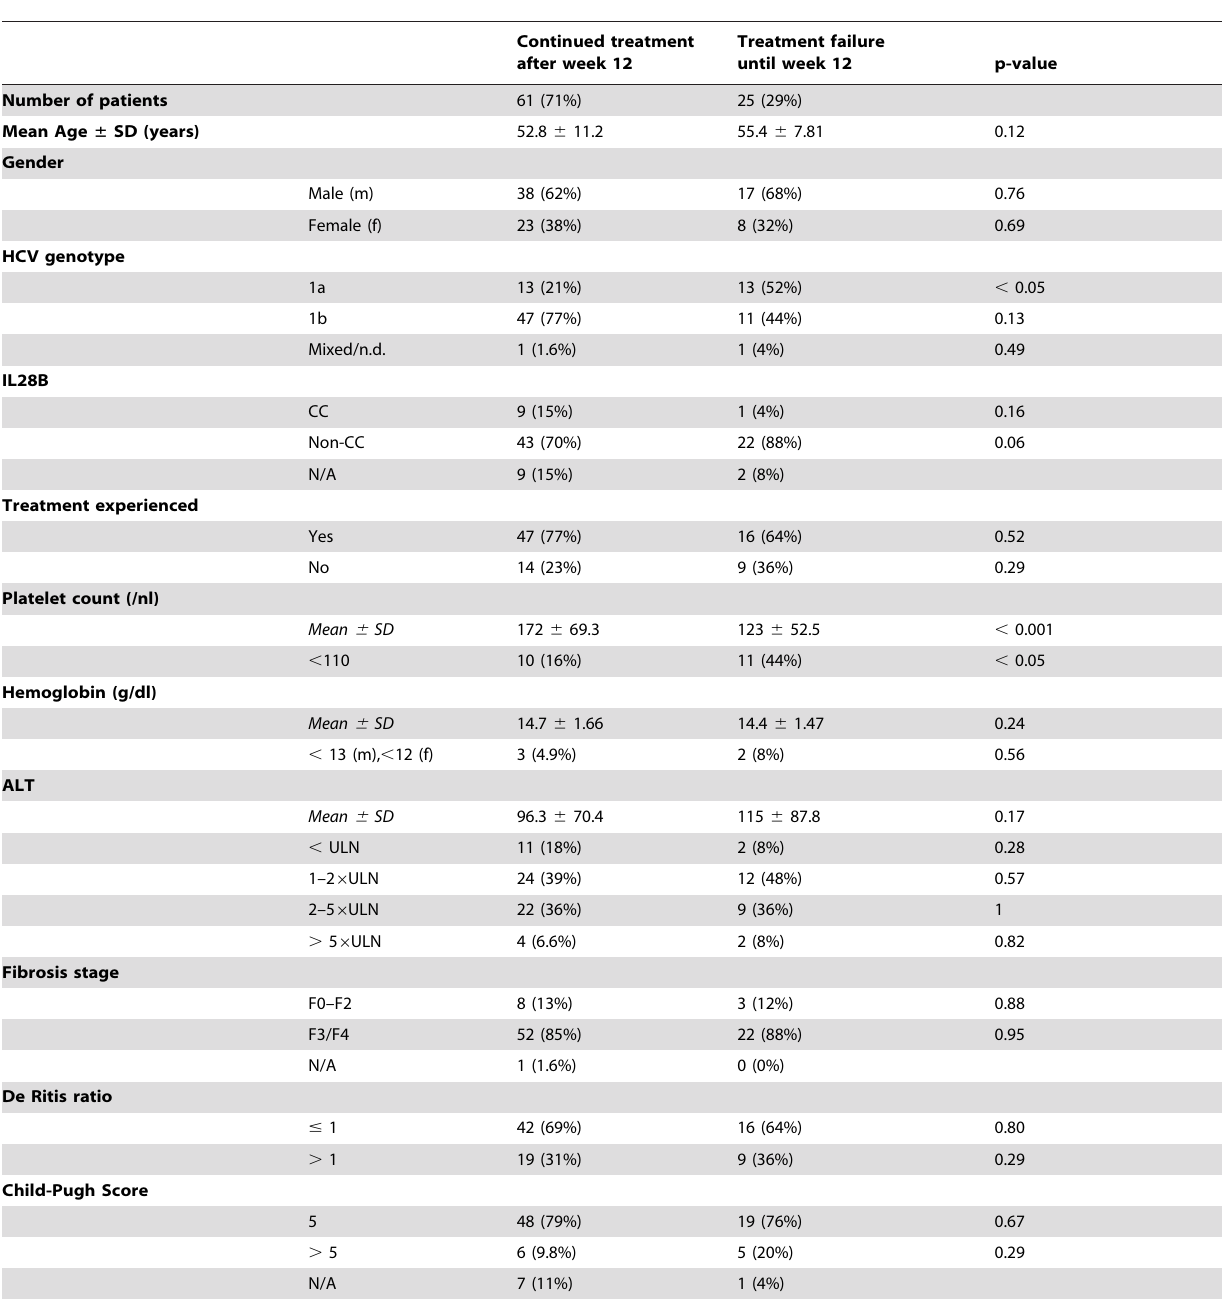
Table 4. Baseline characteristics of patients with and without treatment failure until week